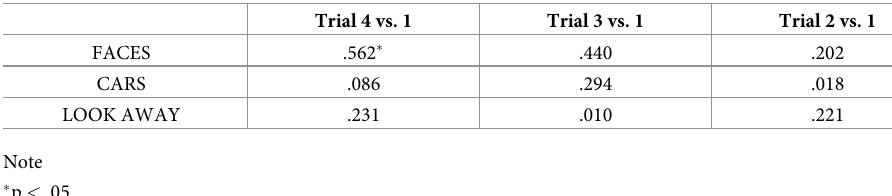
Table 1. Bivariate correlations between NNS burst and eye gaze differences across